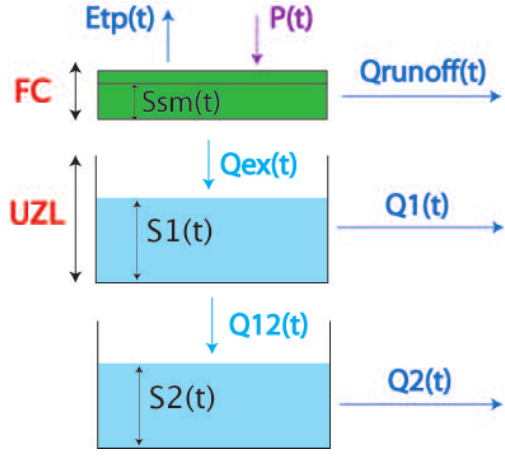
Fig. 3. Configuration of the HBV model at the sub-basin